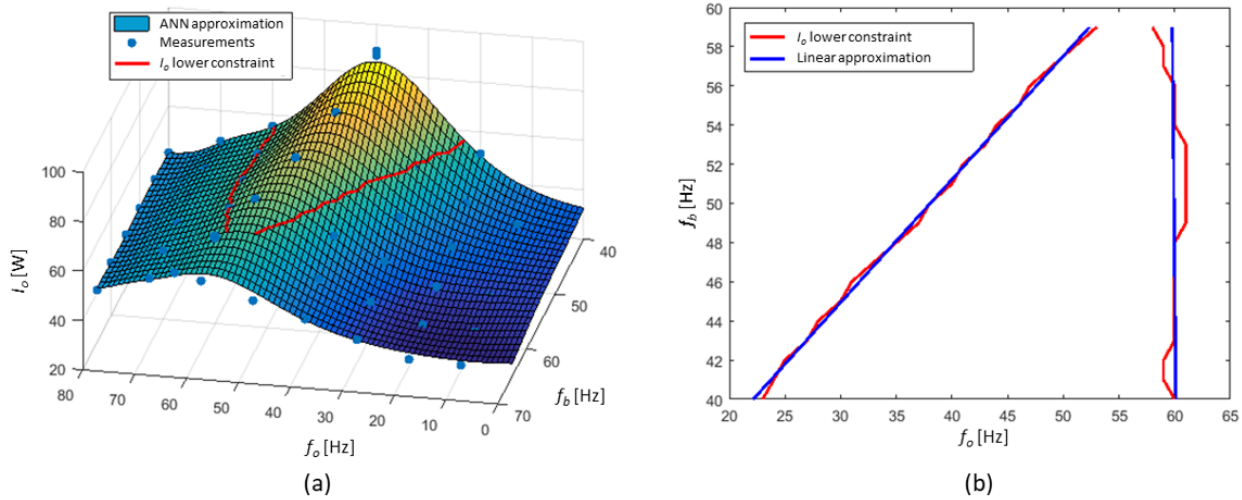
Figure 8. ( a ) The current and its approximation by ANN; ( b ) the current limitation and its linear approximation.